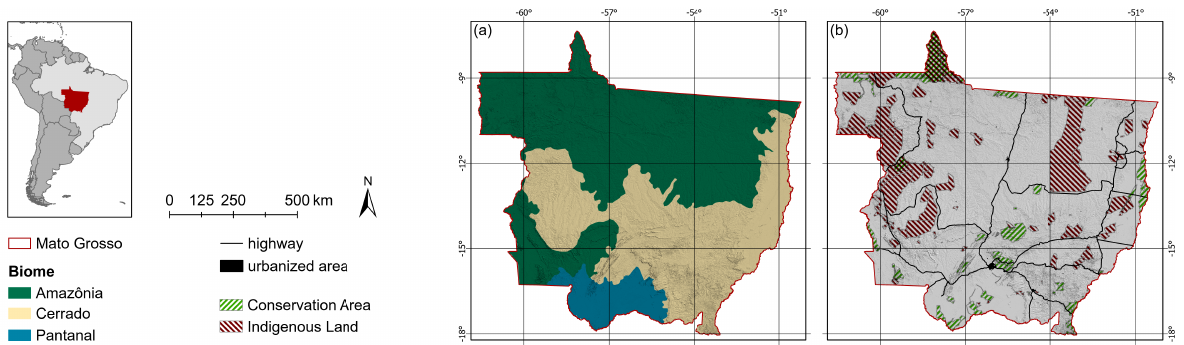
Figure 1. Study area of Mato Grosso: ( a ) biomes and ( b ) protected areas, highways and urbanized areas (data from